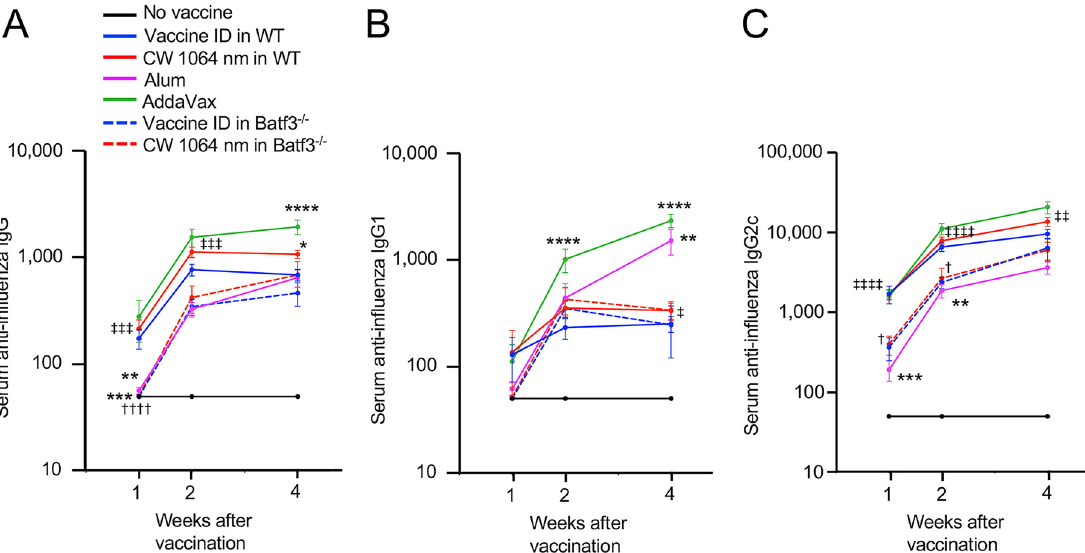
Figure 2: TheeffectofNIRlaseradjuvantonearlyantibodyresponsesandacriticalroleofskintheclusterofdifferentiation103 + (CD103 + )dendritic cells (DCs) in the antibody responses. The effect of NIR laser on anti-in fl uenza antibody responses was evaluated in wild type (WT) and CD103 + DC-de fi cient the basic leucine zipper transcription factor ATF-like 3 knockout (Batf3 − / − ) mice. WT and Batf3 − / − mice were vaccinated intradermally (ID) with 1 µg of inactivated in fl uenza virus (A/PR/8/34) with or without the NIR laser exposure or alum or AddaVax adjuvant. Immune correlates were analyzed at weeks 1, 2, and 4. Plates for enzyme-linked immunosorbent assay (ELISA) were coated with the inactivated in fl uenza virus. Serumanti-in fl uenzaspeci fi c(A)immunoglobulinG(IgG),(B)IgG1,and(C)IgG2careshown.(A – C) n =30,38,34,14,25,5,8fornovaccine,vaccine ID only in WT, vaccine ID + NIR laser in WT, vaccine + Alum ID, vaccine + AddaVax ID, vaccine ID only in Batf3 − / − , vaccine ID + NIR laser in Batf3 − / − groups, respectively. P values are based on a two-way treatment by time ANOVA with Tukey post hoc tests. * P < 0.05, ** P < 0.01, *** P < 0.001, **** P < 0.0001 as compared to the ID-only group in WT mice; † P < 0.05, †††† P < 0.0001 as compared to the NIR laser group in WT mice; ‡ P < 0.05, ‡‡ P < 0.01, ‡‡‡ P < 0.001, ‡‡‡‡ P < 0.0001 as compared to the alum